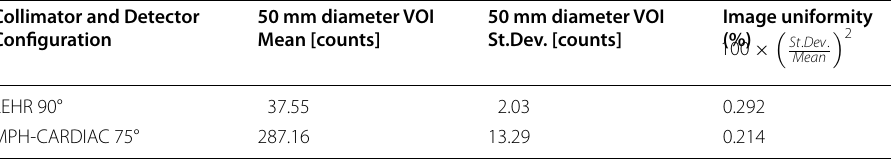
Table 2 The table displays the measured Mean and St.Dev. accumulated count values within the applied 50 mm diameter VOI, and the calculated image uniformity Collimator and Detector